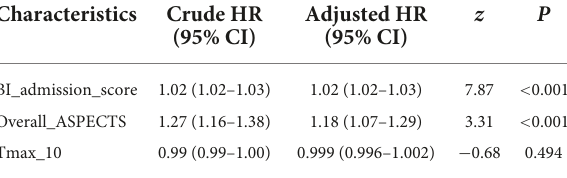
TABLE 4 Cox proportional hazard model based on the features selected by LASSO.